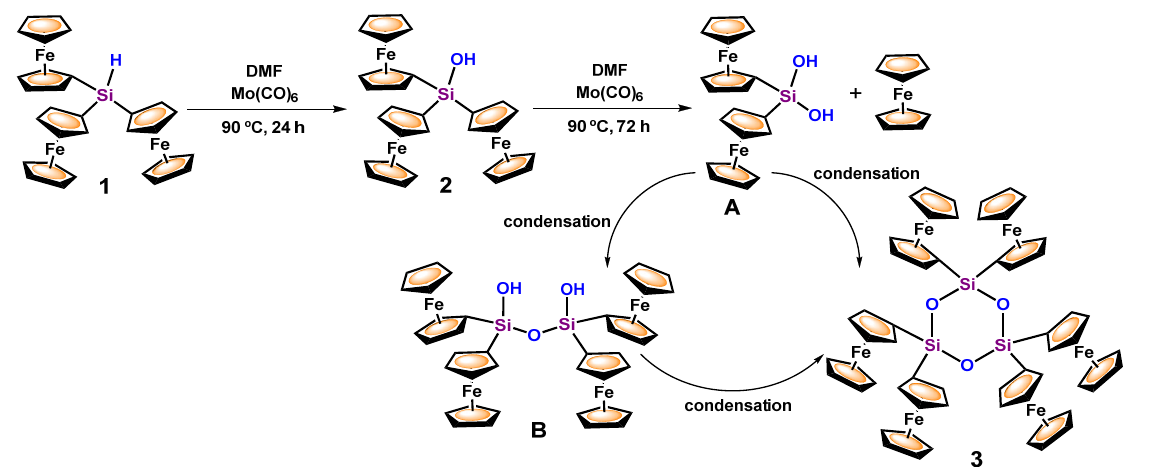
Scheme 3. Proposed route for the formation of cyclotrisiloxane 3